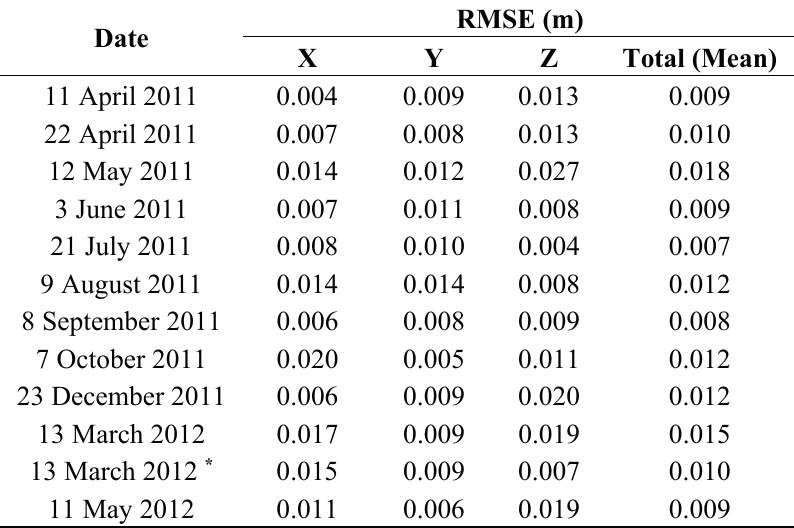
Table 4. Root mean square error (RMSE) of LiDAR data registration to local coordinate system determined for each LiDAR data collection